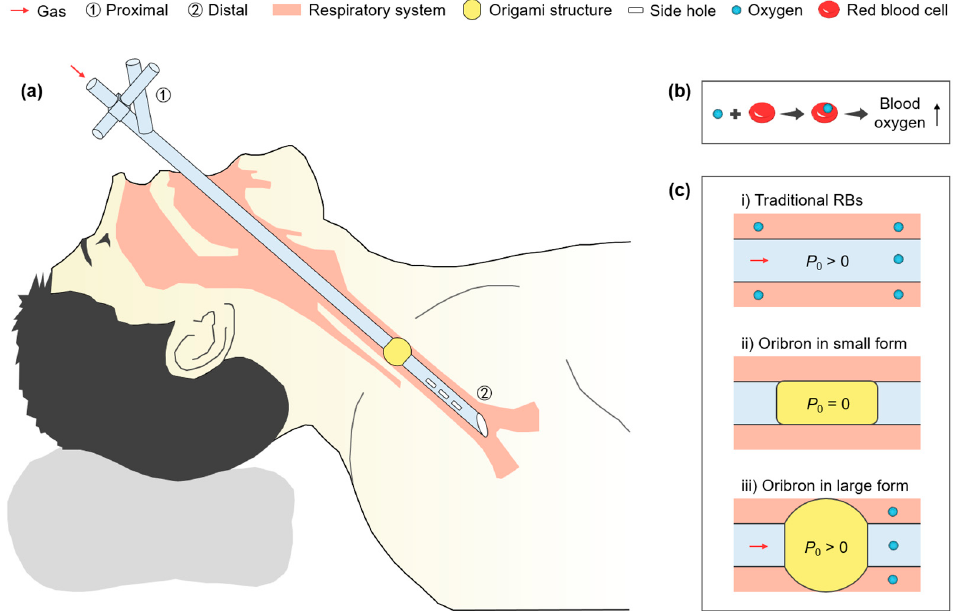
Figure 1. The design principle of Oribron. ( a ) Application. The blue area represents traditional RBs and together with the yellow area form Oribron. ( b ) The principle of increasing blood oxygen. ( c ) Oxygen supply effect of the traditional RBs and Oribron.